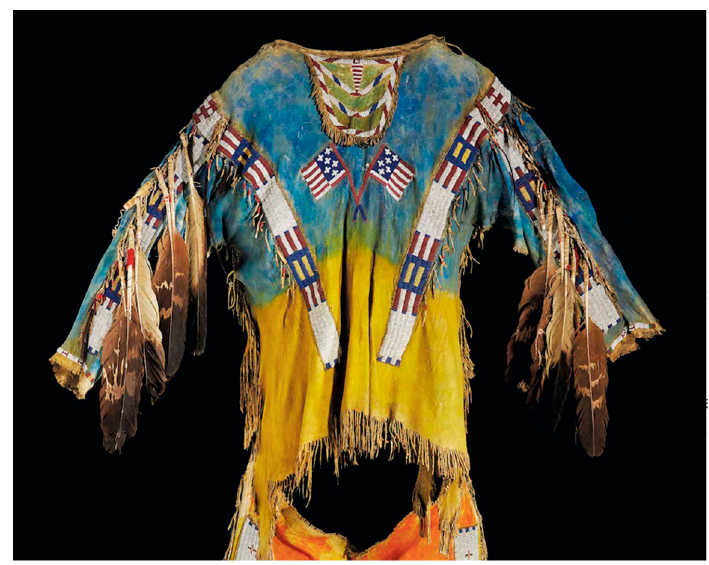
Figure 3. Plains Indian buckskin tunic (detail of Figure 1), c. 1888, beadwork, eagle feathers, paint, and quillwork on deerskin. Musée de l’Atelier Rosa-Bonheur, Château de By, Thomery, France. Photograph taken by Christie’s Paris. Used by permission of the Mus é e de l’Atelier Rosa-Bonheur.